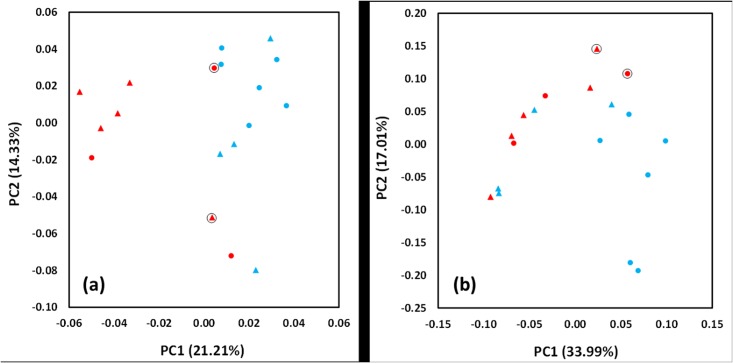
Principal component analysis of taxonomy and functional classifications.PCA plots were created using (A) taxonomic and (B) functional classifications, using the analysis method detailed previously. Control samples are coloured blue and COPD red. Triangles indicate patients who are current smokers, and black circles indicate the patient has antibiotic use in their medical history prior to giving a sample. PCA plots drawn using normalised values and Manhattan distance.